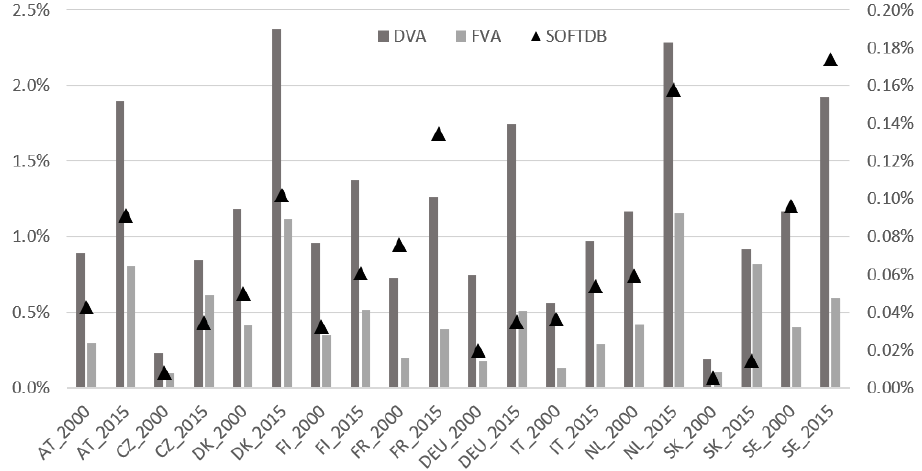
Figure 1. Standardised domestic value-added share of gross exports (DVA), foreign value share of gross export (FVA), and standardised (ratio to total hours worked) intangible ICT assets (SoftDB).